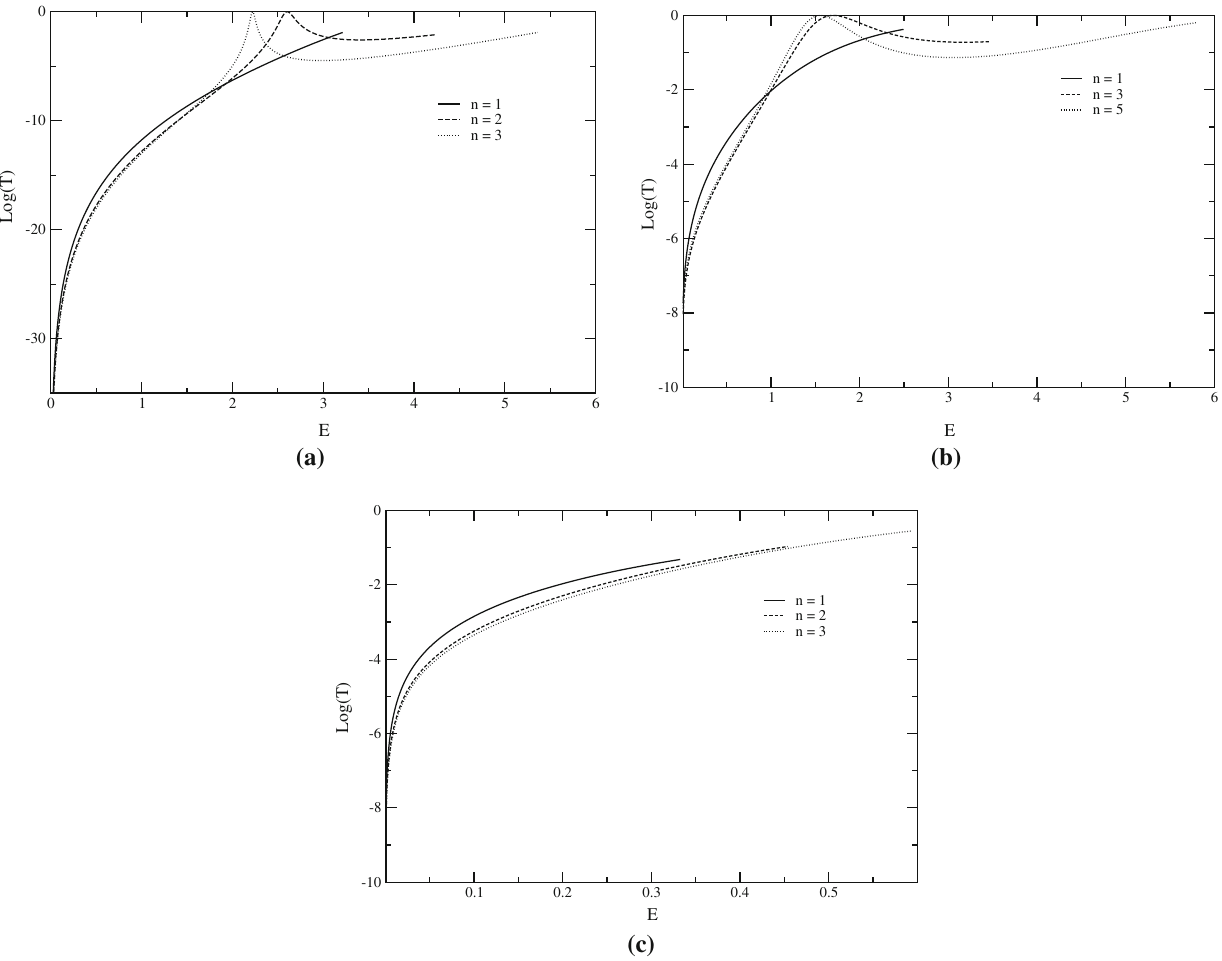
Fig. 4 The transmission coefficient in a smooth scenario generated by domain walls for some values of parameter n as function of E = m 2 Ricci tensor, b Einstein tensor and c Horndeski